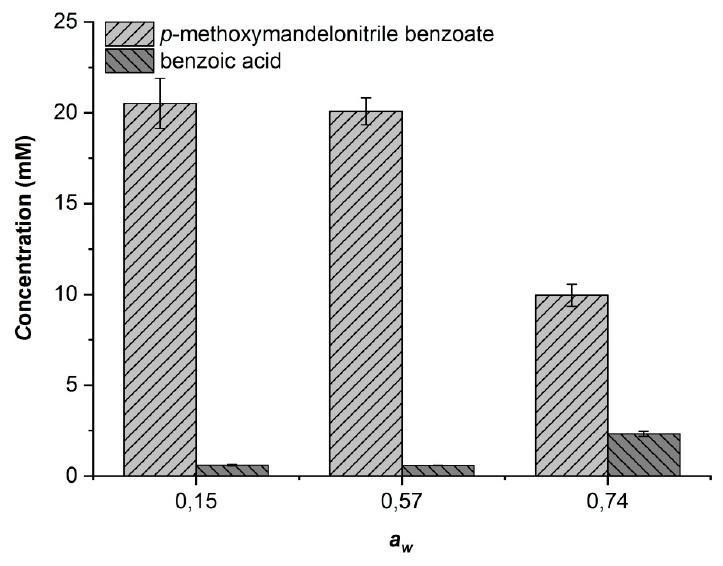
Figure 4. E ff ect of the di ff erent phosphate hydrate pairs on the CALA-catalyzed benzoylation of 66 Figure 4. Effect of the different phosphate hydrate pairs on the CALA-catalyzed benzoylation of 66 mM ( ± )-4-methoxymandelonitrile using 200 mM vinyl benzoate after 22 h of mM (±)-4-methoxymandelonitrile using 200 mM vinyl benzoate after 22 hours of reaction.